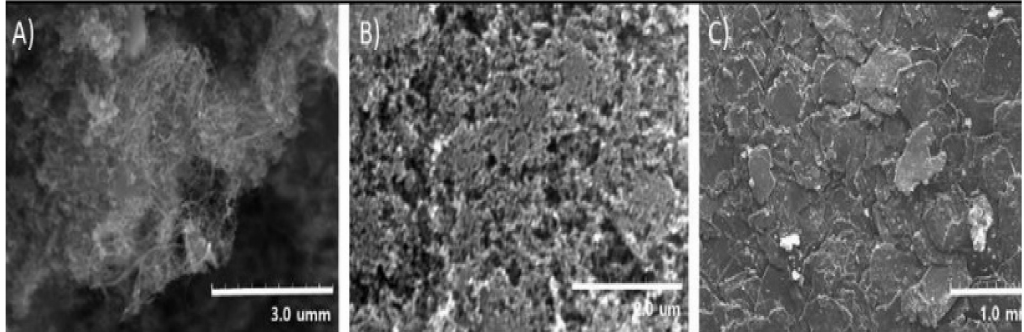
Figure 7. SEM image of conductive carbon fillers. ( A ) Wire-shaped CNT (diameter: < 20 nm, length: < 5 µ m), ( B ) spherical-shaped CCB ( < 35 nm), and ( C ) disc-shaped graphite.